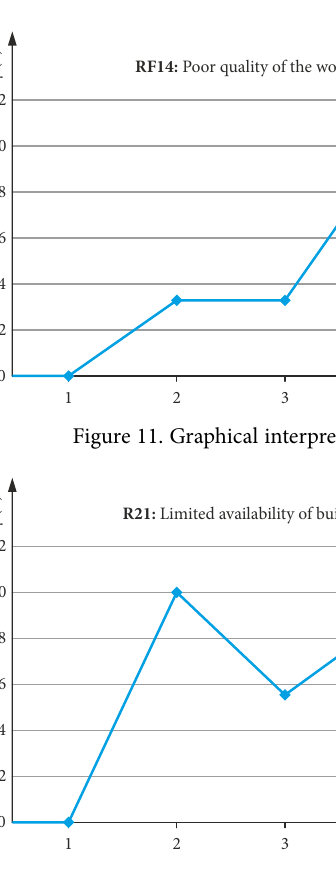
Figure 12. Graphical interpretation of fuzzy numbers for risk factors RF 21 – left and RF 23 – right (own study) Table 9. The results of expert studies of risk impact assessment on the size of the life cycle costs of buildings in relation to fuzzy measures using various deffuzification methods (own study) Risk factors (RF)